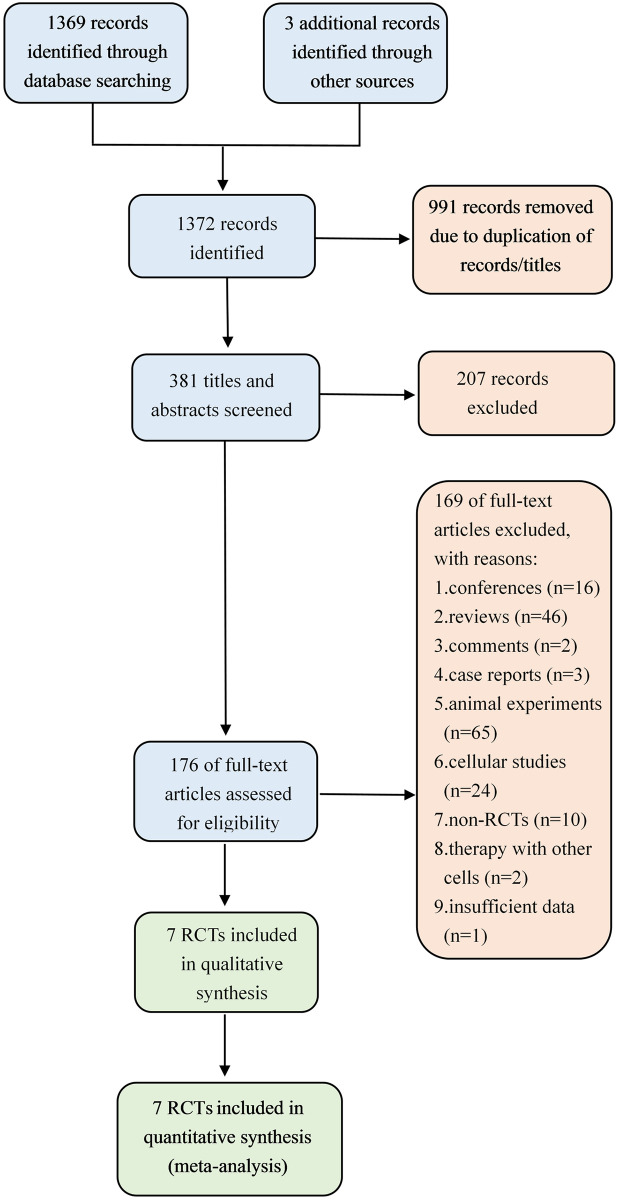
Flow diagram showing the study identification, screening, and inclusion process.